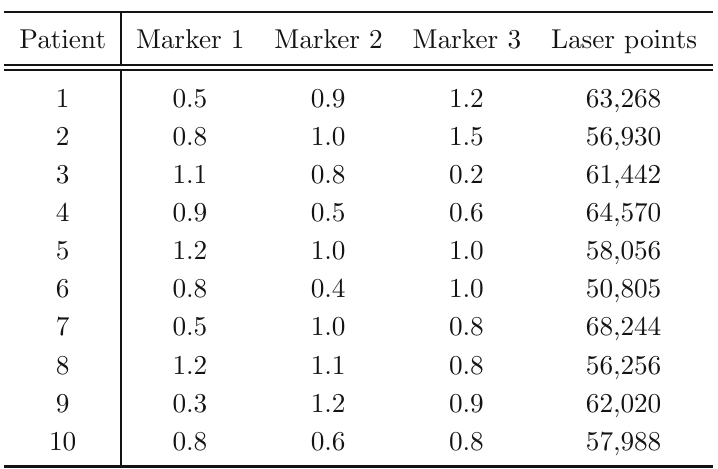
Table 3 Accuracy of detection (in mm) of intraoral markers in regions 16, 11 and 26 after laser surface registration of the